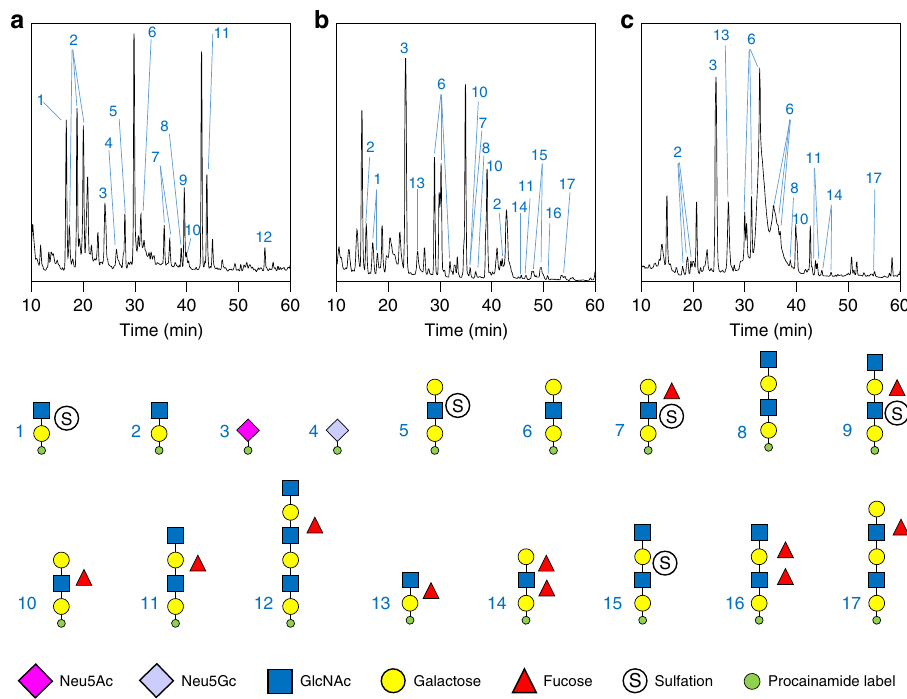
Fig. 7 Examples of the O-glycan pro fi les that can be produced from a variety different human mucins by the Amuc_0724 O-glycanase. Mucins from different samples were pre-treated with the broad acting sialidase BT0455 GH33 and then digested with the GH16 and products analysed by LC-FLD-ESI- MS. a In fl amed colonic tissue removed during a laproascopic panproctocolectomy from a patient with UC. b Bowel tissue from neonates with necrotising enterocolitis. c Colorectal cancer cell lines. Small amounts of Neu5Gc are seen in some of the UC samples (e.g., panel a ) suggesting either the presence of contaminating dietary animal O-glycans remaining in the mucus layer or that this xenobiotic sugar has been incorporated into human mucins from dietary sources. The O-glycan pro fi les of all the different samples analysed are shown in Supplementary Fig.